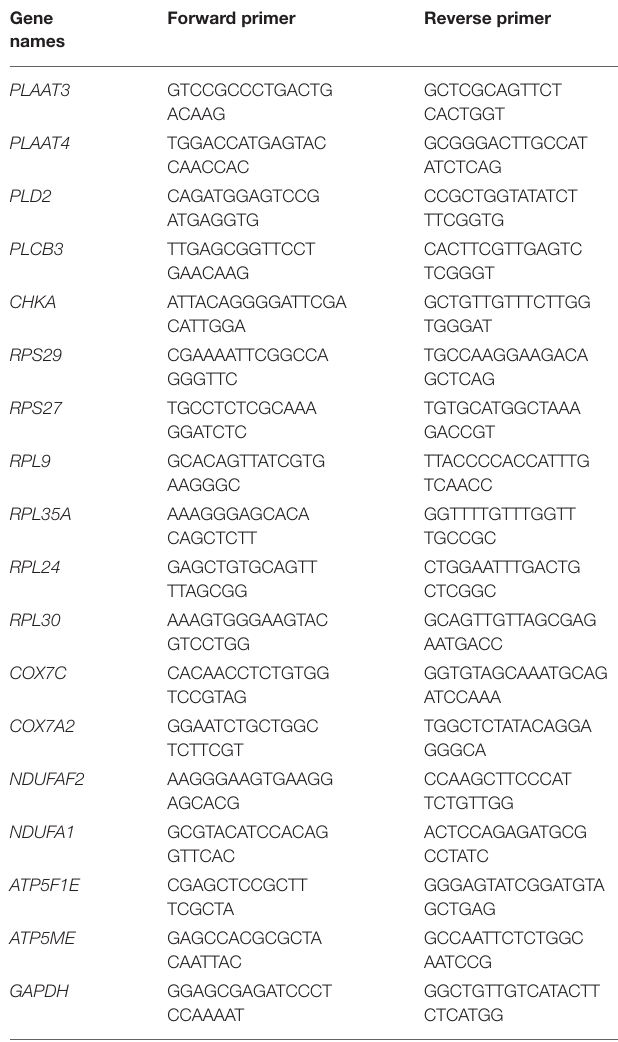
TABLE 1 | Primer sequences used for qPCR